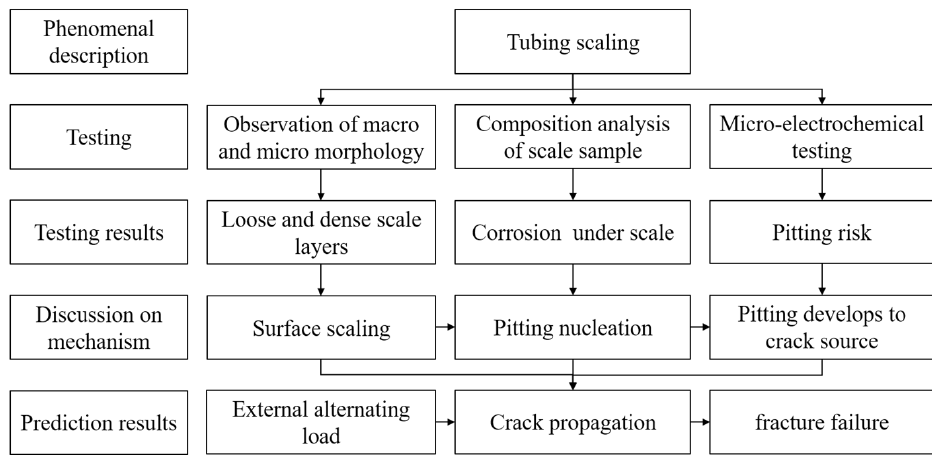
Figure 2. Schematic Diagram of Research Concept in This Paper.